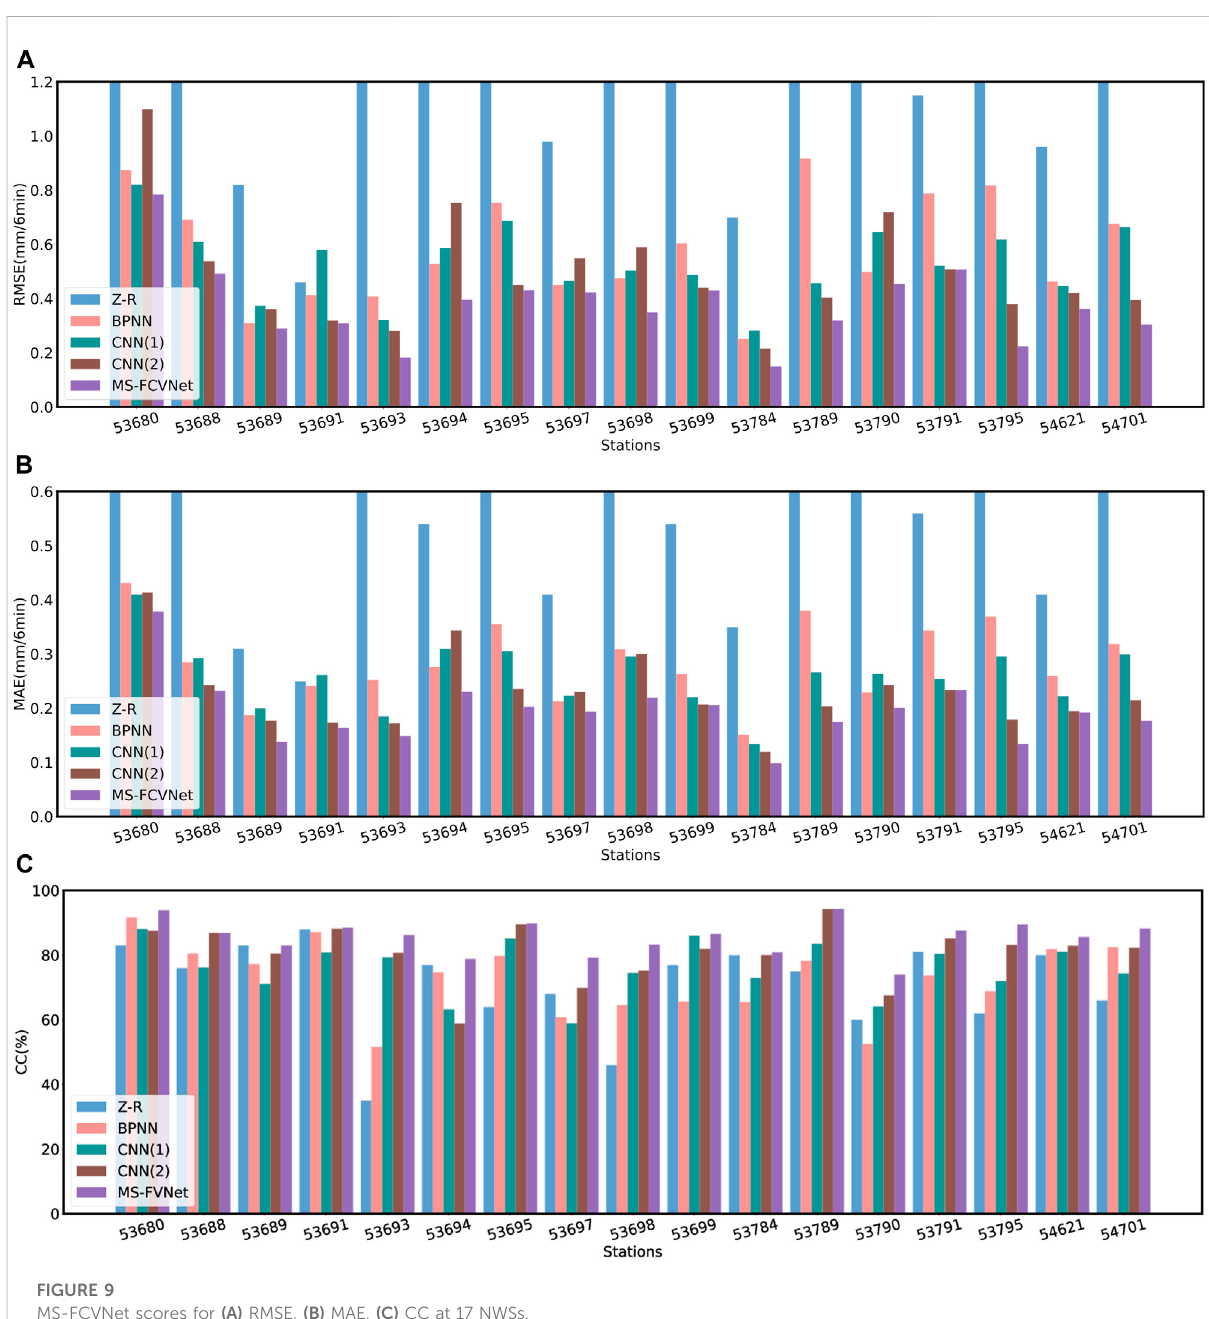
FIGURE 9 MS-FCVNet scores for (A) RMSE, (B) MAE, (C) CC at 17